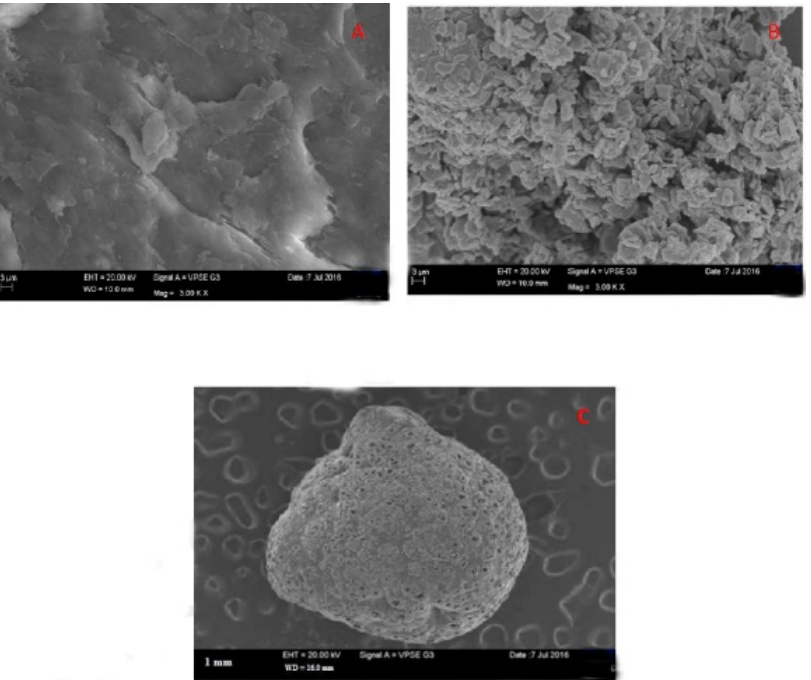
Figure 22. SEM images of various prepared CS/PVA/ZnO-related materials and precursors: ( A ) pure chitosan, ( B ) ZnO, and ( C ) CS/PVA/ZnO. Reprinted/adapted with permission from Ref. [204]. Copyright© 2022, Elsevier B.V.